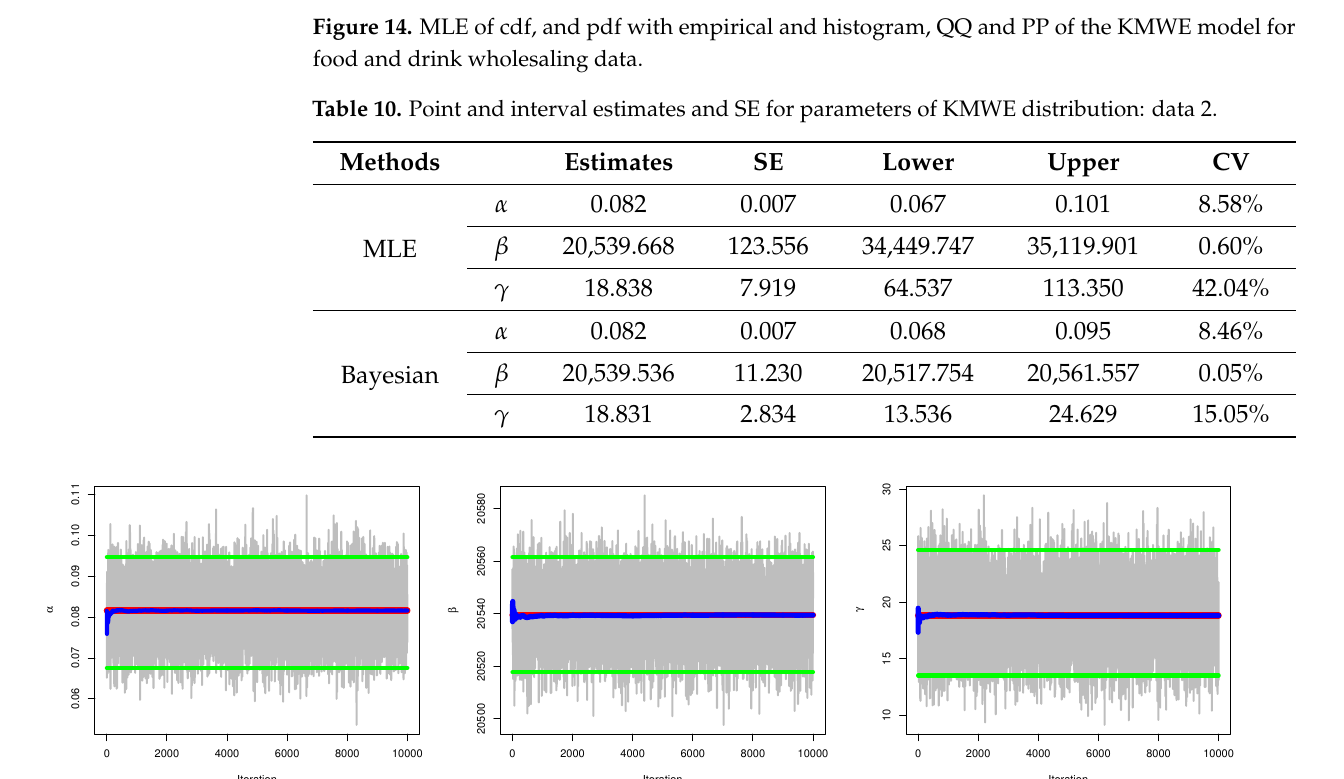
Figure 15. MCMC plot and convergence line for parameters of the KMWE model for food and drink wholesaling